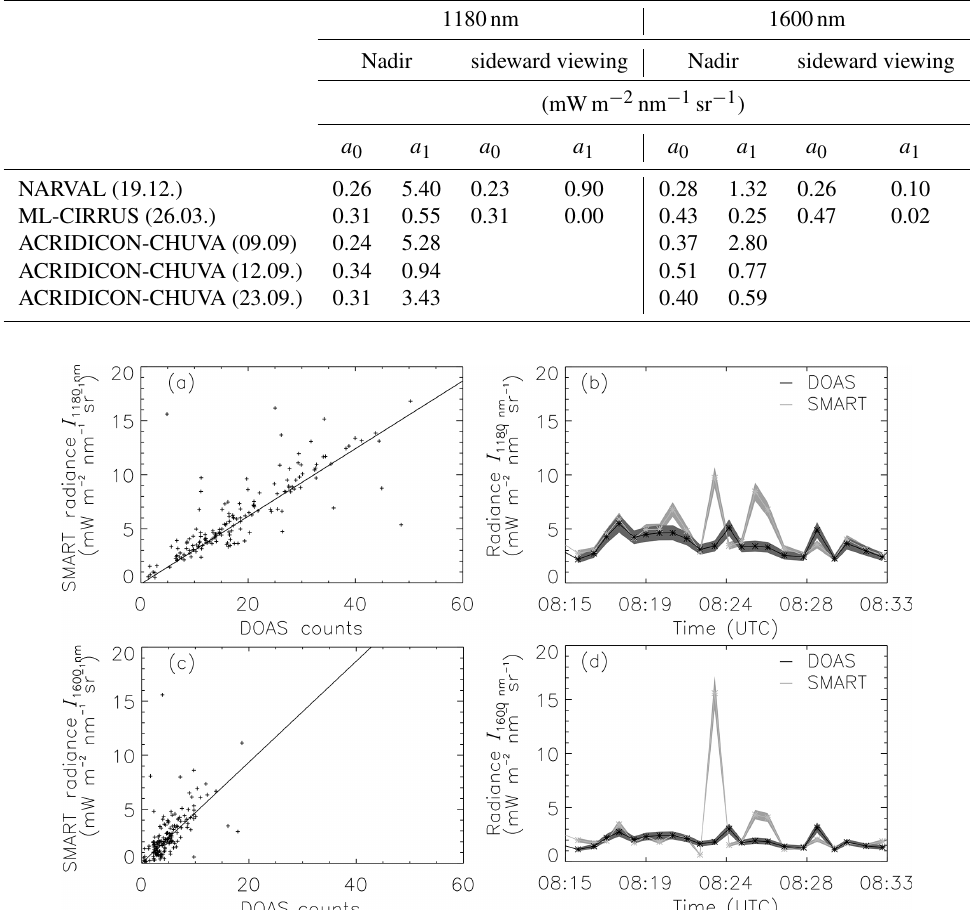
and mini-DOAS raw signal N V for the scanning channels at mD ,λ S ,λ and calibrated mini- S ,λ